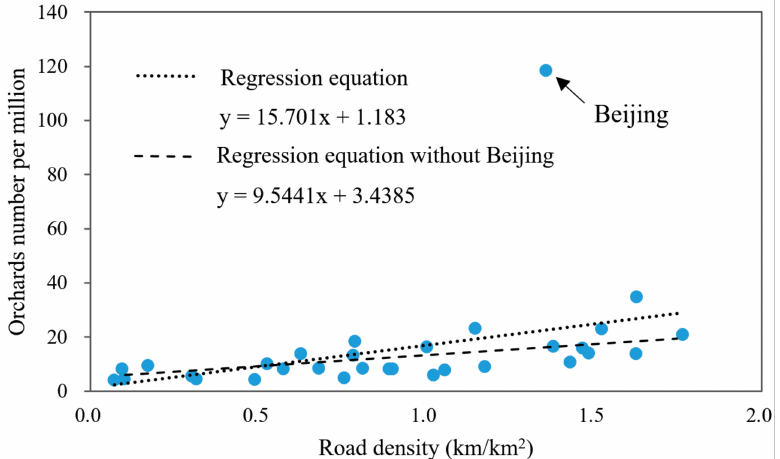
Figure 8. The correlation between traffic conditions and picking orchards (the higher the road density is, the more picking orchards per capita there are).